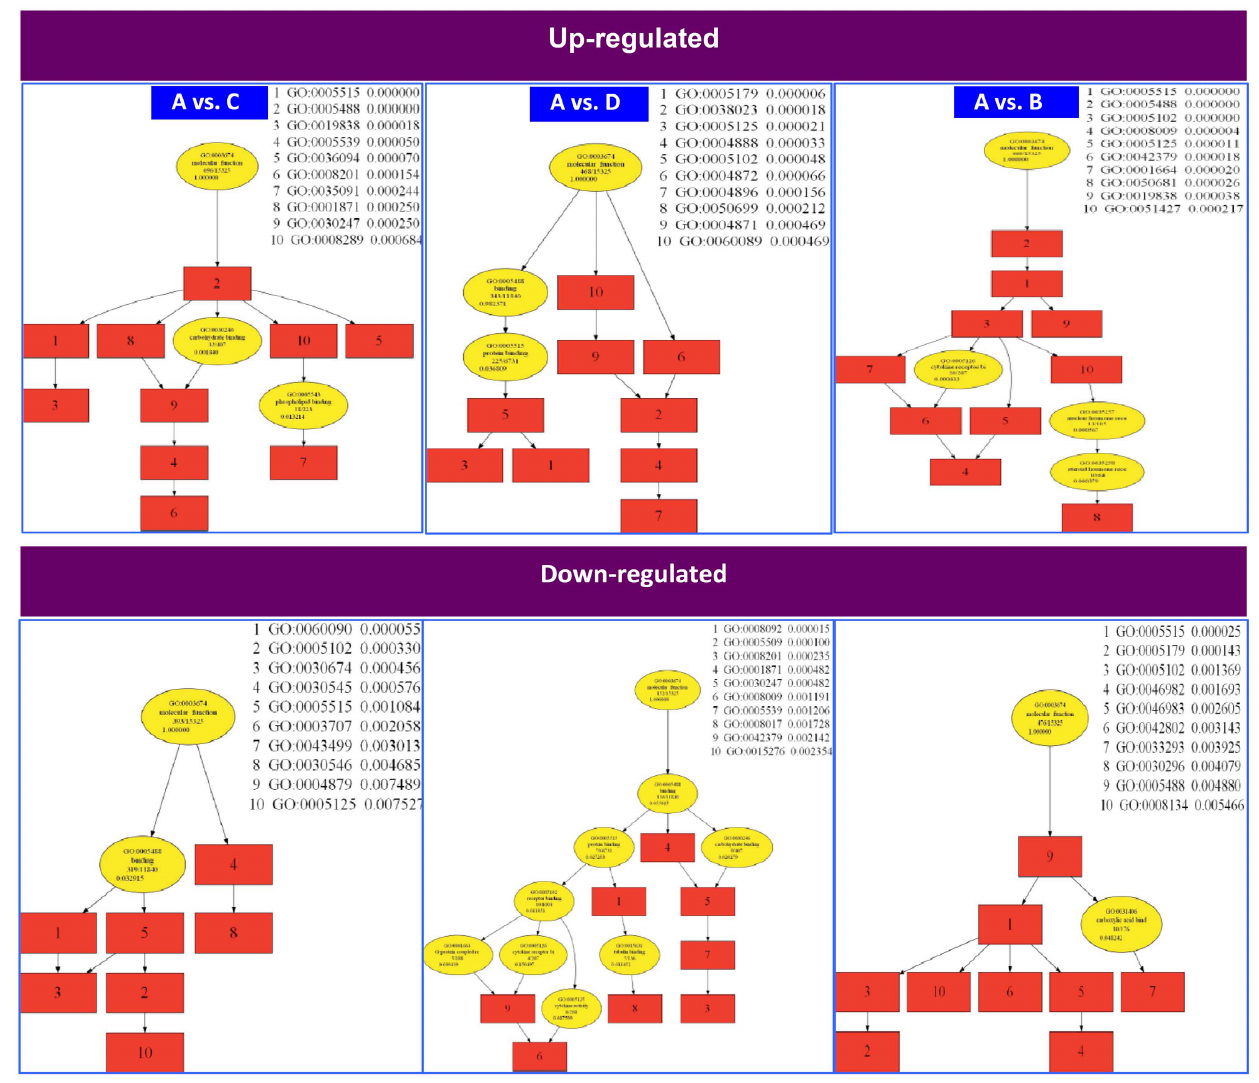
Figure 4. GO molecular functional annotations. Functional relationship presented with GO ‘‘trees’’ for the top 10 ( p , 0.005) GO annotations (Table 3) is shown for both up- and down-regulated A vs. B, A vs. C, and A vs. D. The red color labels indicate the top 10 GOs. The yellow colors show GOs with lower p value, which were not presented in Table 3 but could be identified from the differentially expressed lncRNAs in PPROM, FT, PRTB, and PROM.